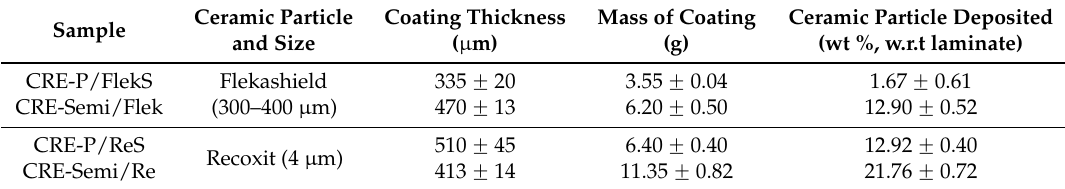
Table 1. Physical properties of the carbon fiber-reinforced (CRE) composite (75 mm ˆ 150 mm plaque) samples and the coatings applied on the surfaces of the composite samples. P = phenolic, Cp = ceramic particle: Flek (Flekashield) or Re = (Recoxit) and S = sieved.